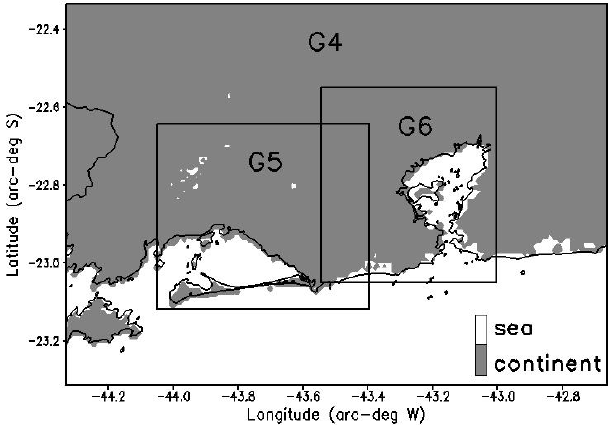
Figure 2. The limited areas of G4 (resolution of 1km), and the G5 and G6 innermost grids (resolution of